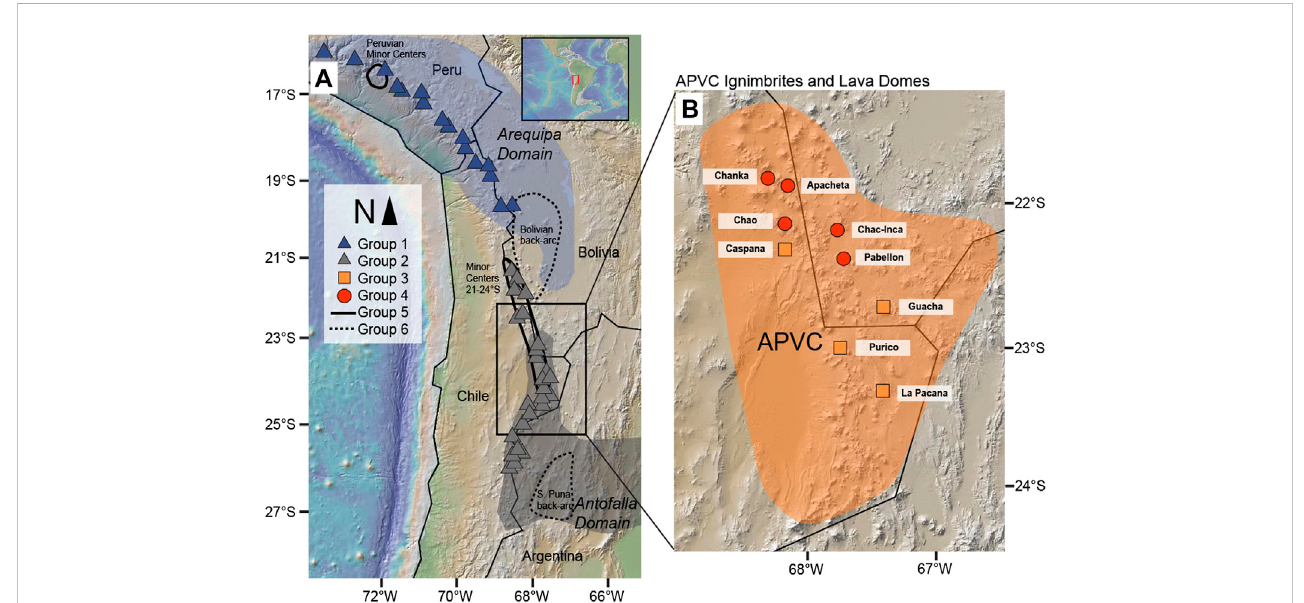
FIGURE 1 Mapsshowingthevarious typesofandesite-bearingeruptivecentersintheCVZ. DiagramincludesSymbols forall panels areexplained inpanel D.These include major eruptive centers (i.e., composite cones) associated with the Quaternary arc (groups 1 and 2), eruptive centers associate the peak of the APVC ignimbrite fl are-up (group 3), small volume centers associated with the waning stages of the APVC fl are-up (group 4), minor centers associated with the arc (group5),andminorcentersfoundbehindthearc(group6).Thelargeblueandgrey fi eldsin (A) showdifferencesintheproposedbasementterrainsthat underly the two arc segments (Mamani et al., 2010). Map in (B) shows the distribution of APVC fl are-up related ignimbrites and domes (orange fi eld) and locations of APVC units discussed in the